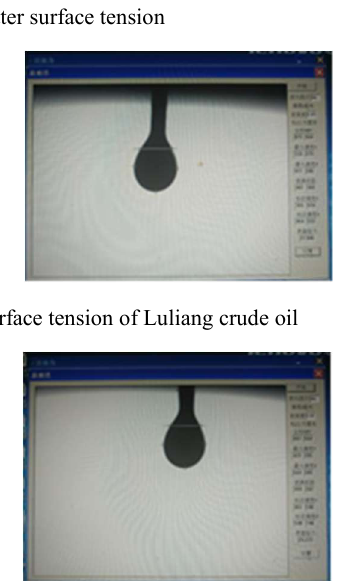
Figure 3. Surface tension of Hongqian crude oil